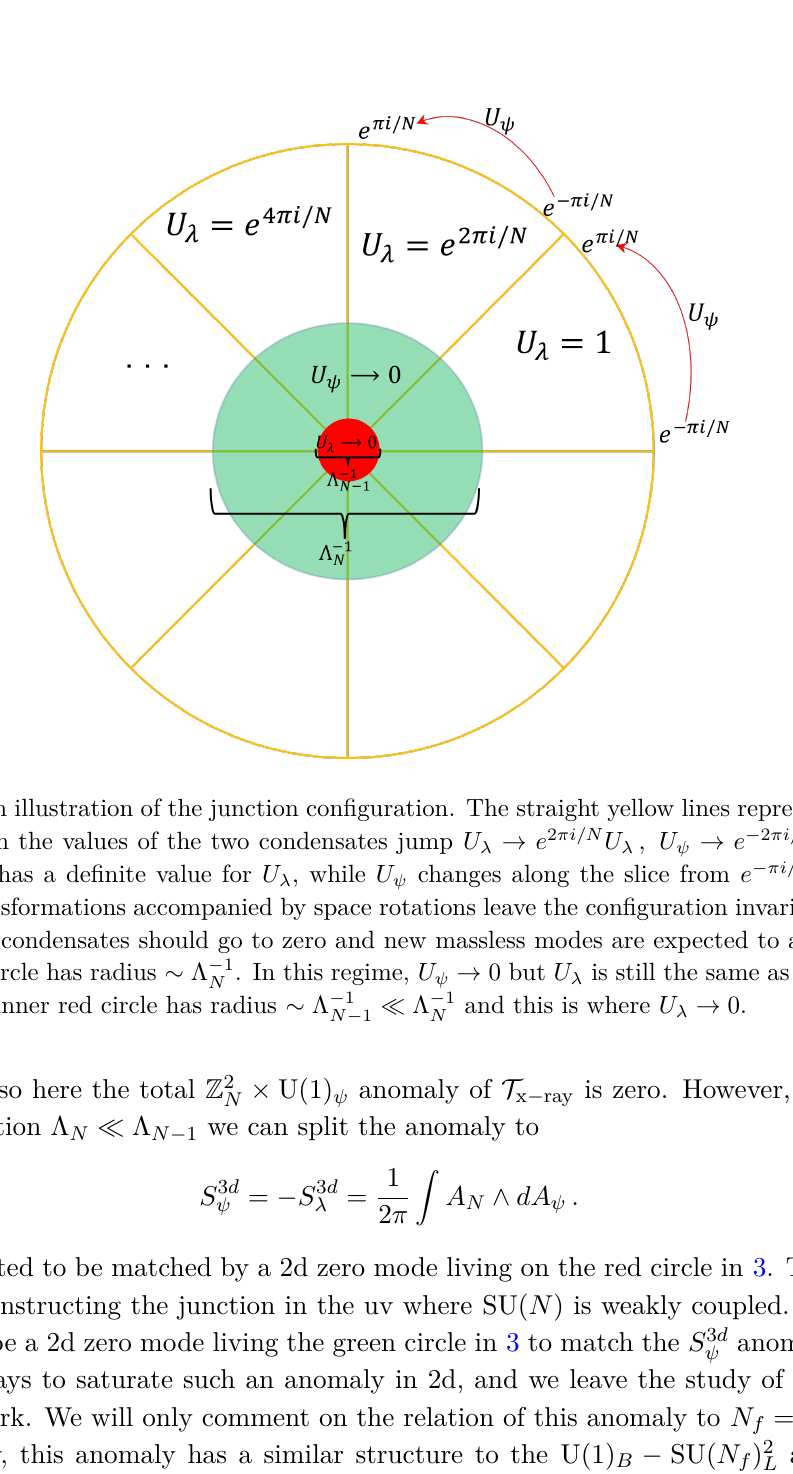
. Each 2 πi/N U − 2 πi/N U λ → e λ , U ψ → e ψ , while U changes along the slice from e − πi/N → e iπ/N . λ ψ . In this regime, U 0 but U is still the same as in the ψ → λ N